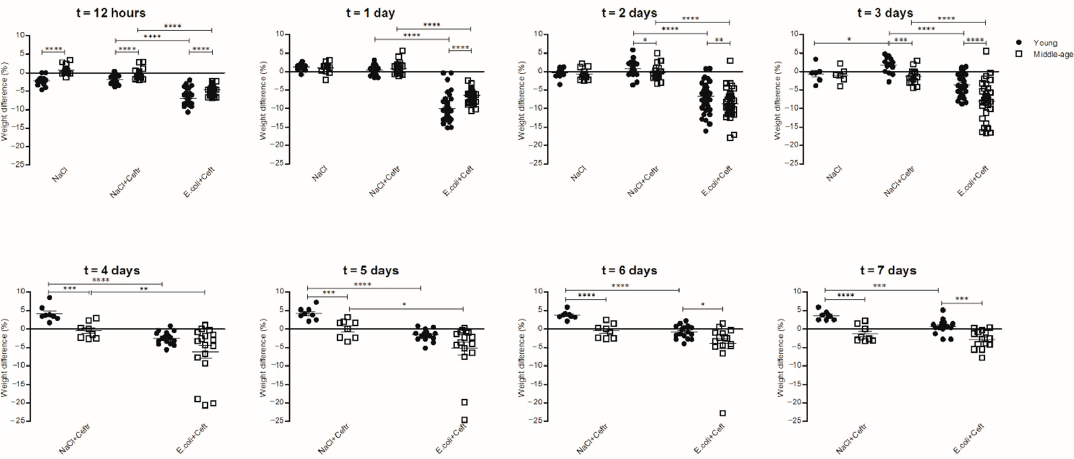
Figure A3. Weight difference per time point in percentage. Student t -tests were performed, data represent mean ± SEM, * p ≤ 0.05, ** p ≤ 0.01, *** p ≤ 0.001, **** p ≤ 0.0001.